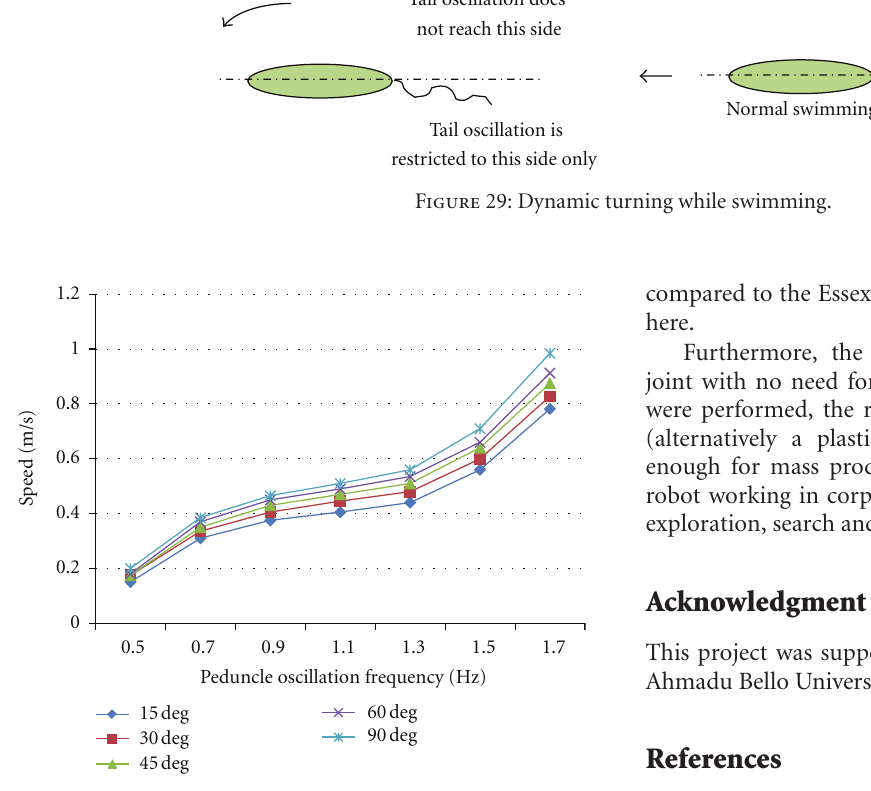
Figure 30: Speed of robot against peduncle (last segment) oscilla- tion at di ff erent peduncle amplitude.